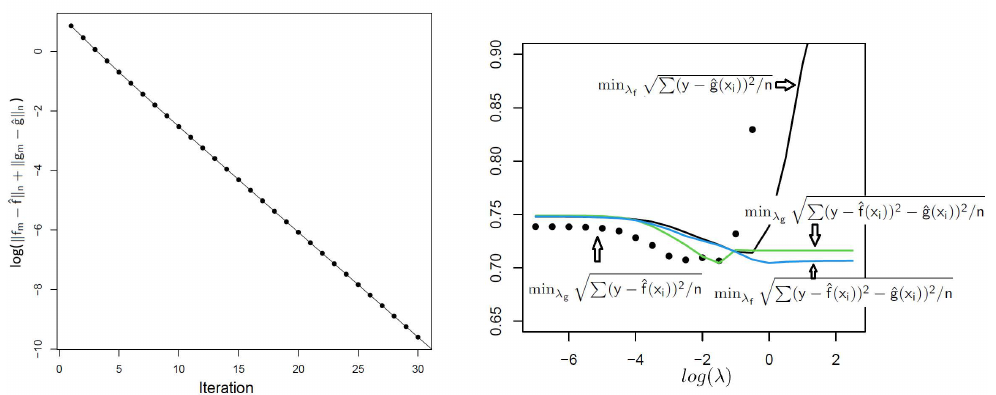
Figure 1. Left panel: Convergence of f m , g m using Algorithm 1 for the diabetes dataset. Right panel: For each curve, the label shows which portion ( f or g has been subjected to minimization, and the x-axis corresponds to the other λ not minimized. The LASSO portion of the elastic net example achieves nearly the same minimum RMSE as the full elastic net for these data, which would be favored in terms of